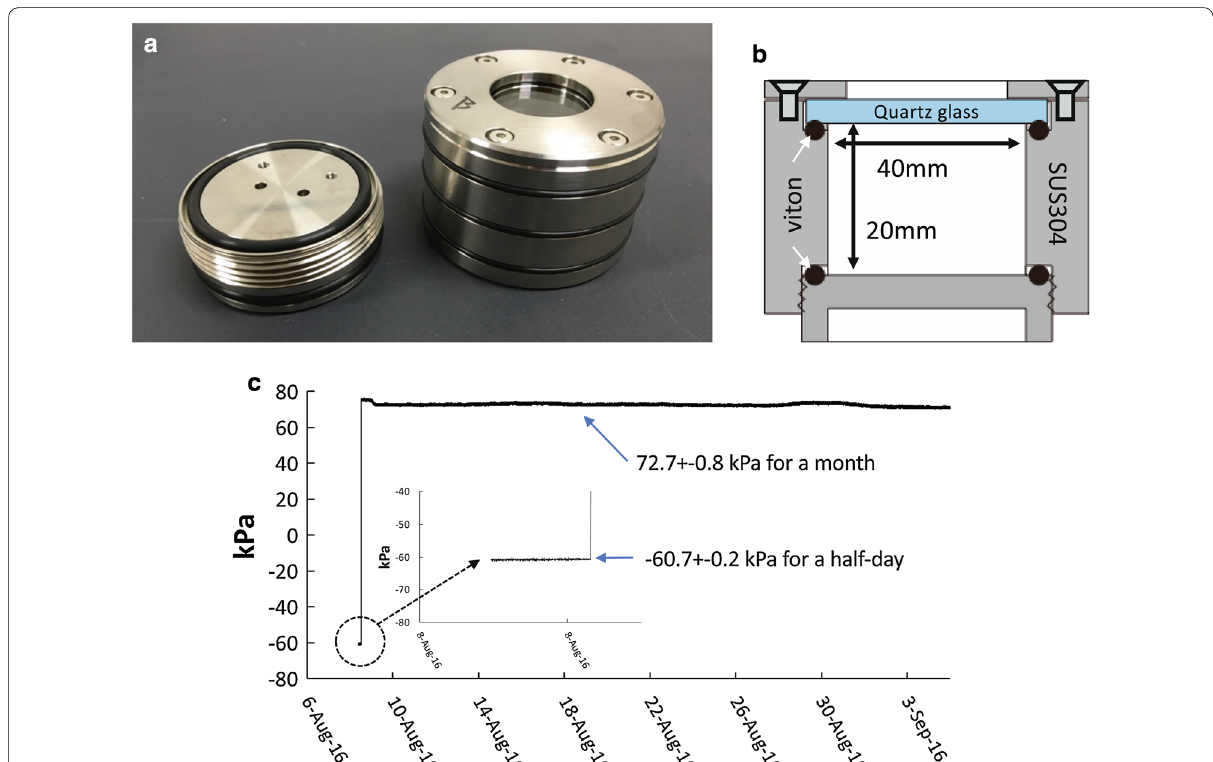
Fig. 1 a Picture of the facility-to-facility transfer container (FFTC), b schematic diagram of the FFTC and c result of the performance test of the FFTC under negative and positive pressures (approximately -61 kPa for a half-d and approximately 73 kPa for a